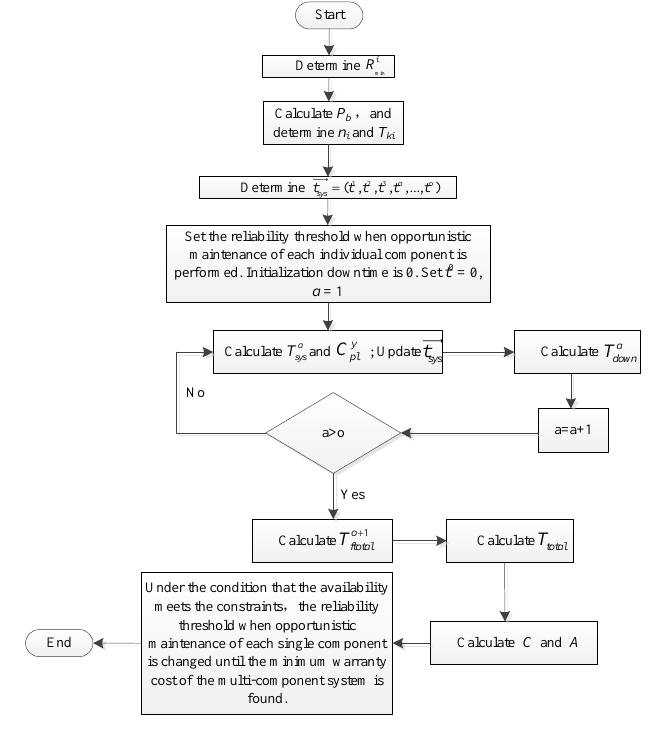
Figure 7. Algorithm flow chart.